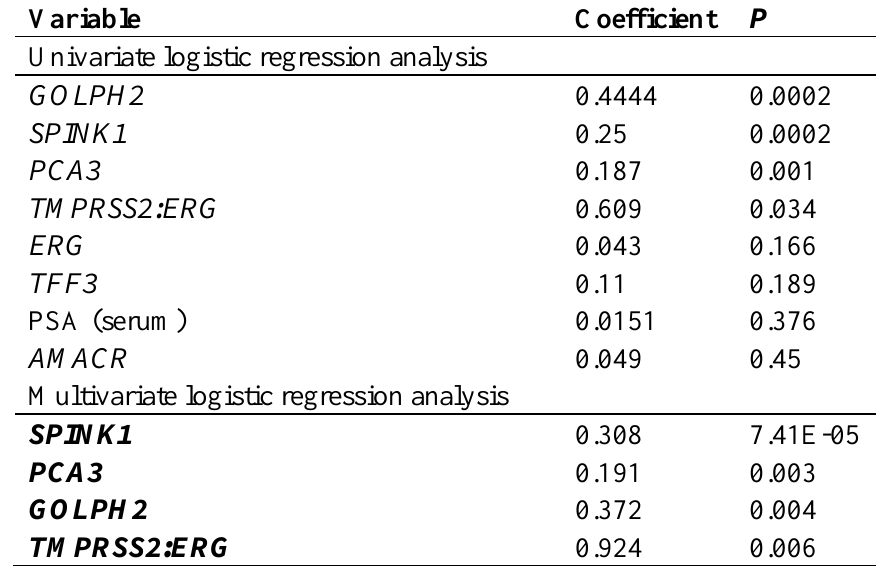
Table 1. Post-prostate massage-urine biomarkers for the detection of prostate cancer from Laxman et al. [26].